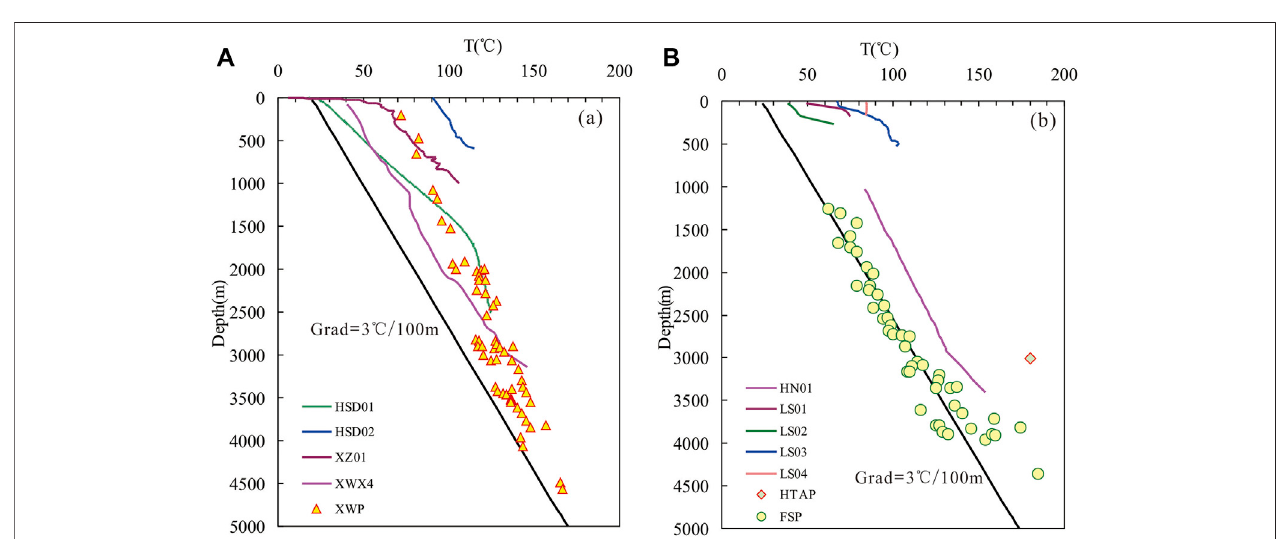
FIGURE5| RepresentativeboreholestemperaturemeasurementcurvesforGuangdong (A) andHainanprovince (B) .HSD01,HSD02,andXZ01-scienti fi cexplorationwells for geothermal energy in Huangshadong and Xinzhou area, XW04- a well for oil exploration in XW area, XWP - bottom temperature of petroleum well measurement in Leizhou Peninsular, HN01 – a well for oilexploration in Fushan depression, LS01-04-borehole from the Lingshuiarea of Hainan province, HTAP-thehotdry rock exploration wellby HTAP Company,FSP-bottomtemperatureofpetroleumwellmeasurementinFushandepression,theblackline-geothermalgradientlinewithaglobalaveragevalueof3 ° C/100 m